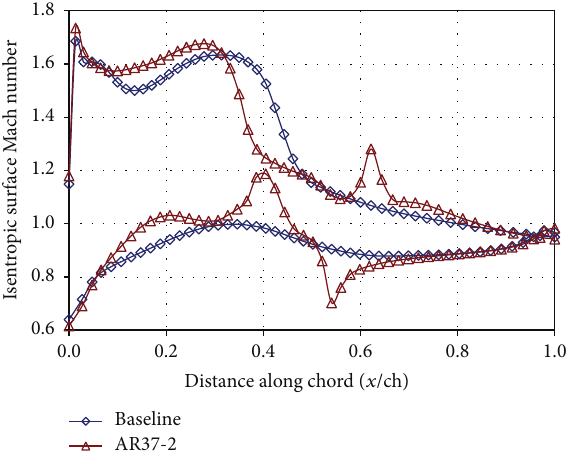
Figure 17: Isentropic Mach number variation on the blade surface with no aspiration and with AR37-2 aspiration slot at a radial location 72.5% span from hub (100% design rotational speed).